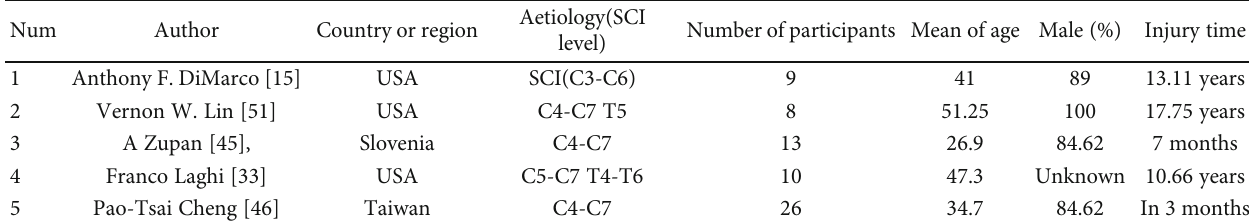
Table 1: Characteristics of participants of included